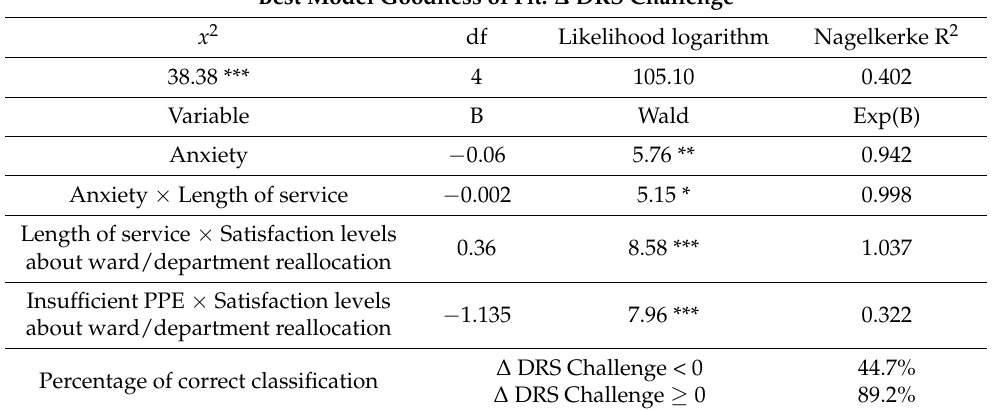
Table 22. Challenge predictors according to multivariate analysis (anxiety, anxiety × seniority of service, anxiety × transfer evaluation, PPE (no) × transfer evaluation) and correct/incorrect classification of the model.